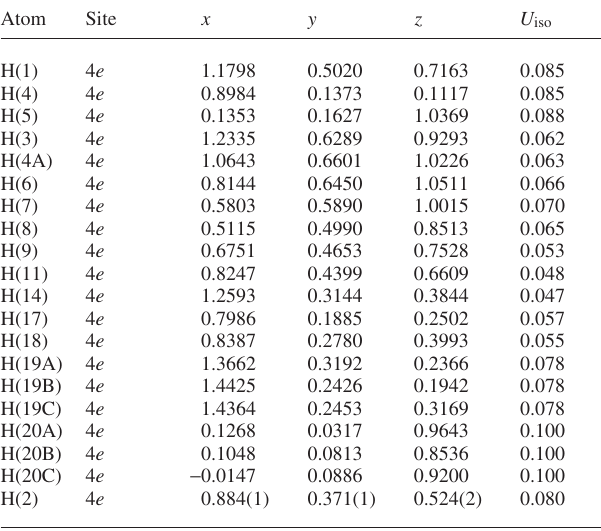
Table 2. Atomic coordinates and displacement parameters (in Å 2 )